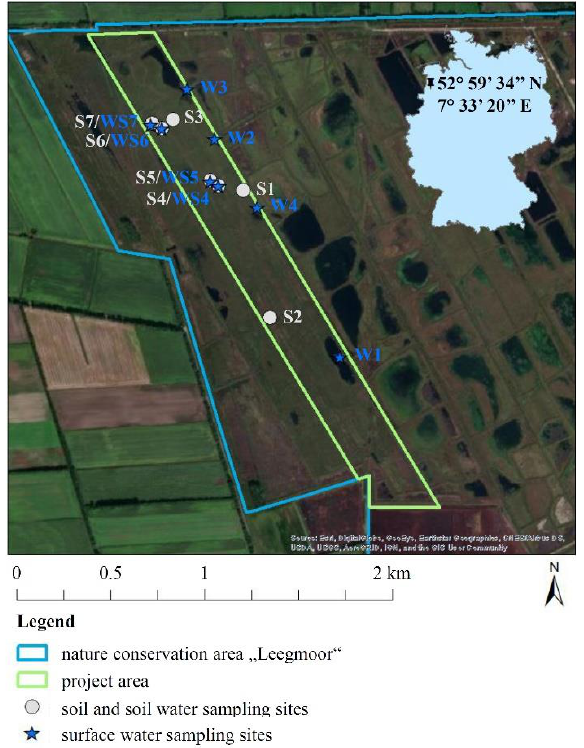
Figure 1. Map of the Leegmoor project area with sampling sites (soil and soil water sampling sites: gradient from S1 = driest to S7 = wettest site; surface water sampling sites: W1 = bog pond, W2 = ditch, W3 and W4 = intermittent ponds, WS4 – WS7 = intermittent surface water at wetter soil sampling